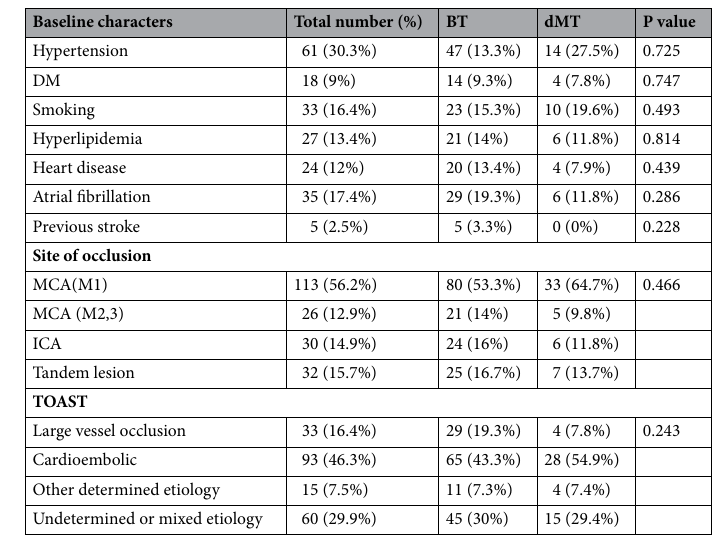
Table 1. Baseline characters in each group. BT bridging therapy, dMT direct mechanical thrombectomy.